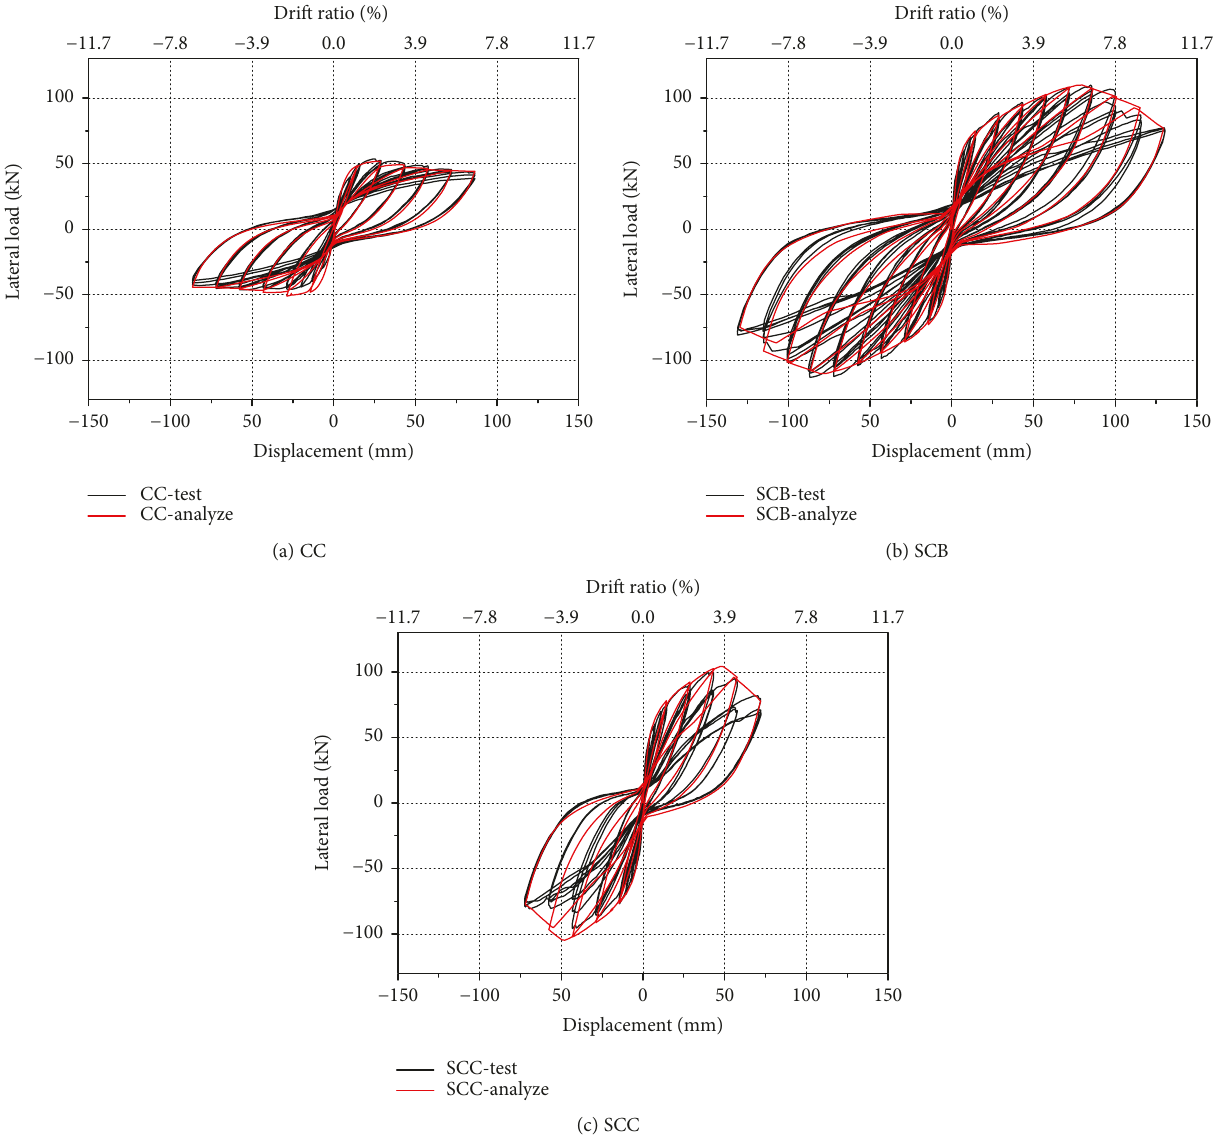
Figure 6: L-D hysteresis curves of all specimens.